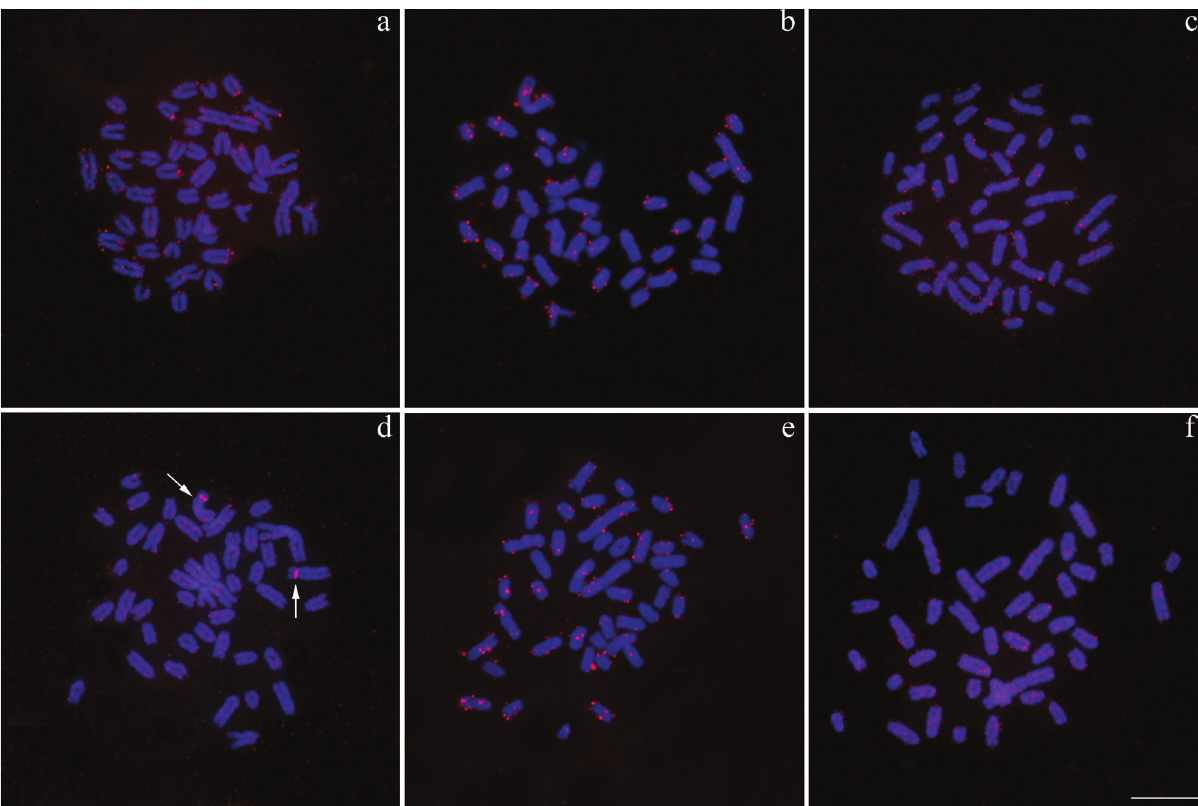
Figure 4 - Metaphases after FISH treatment using Rex1 and Rex3 probes, respectively, in karyomorphs A (a, d), B (b, e), and E (c, f). Arrows indicate the clustering of Rex3 sites in the centromere of a submetacentric pair. Bar = 10 (cid:2)